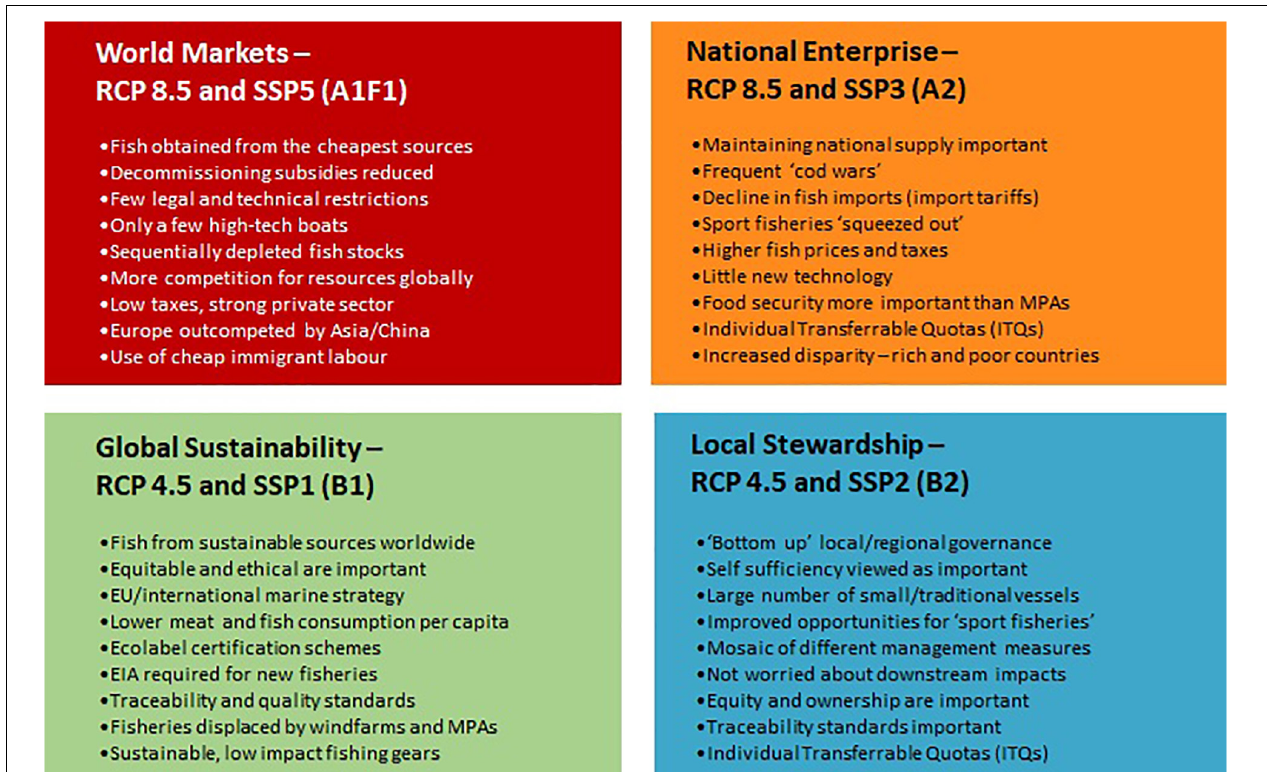
FIGURE 6 | Draft socio-political scenarios elaborated for European fisheries by CERES partners and